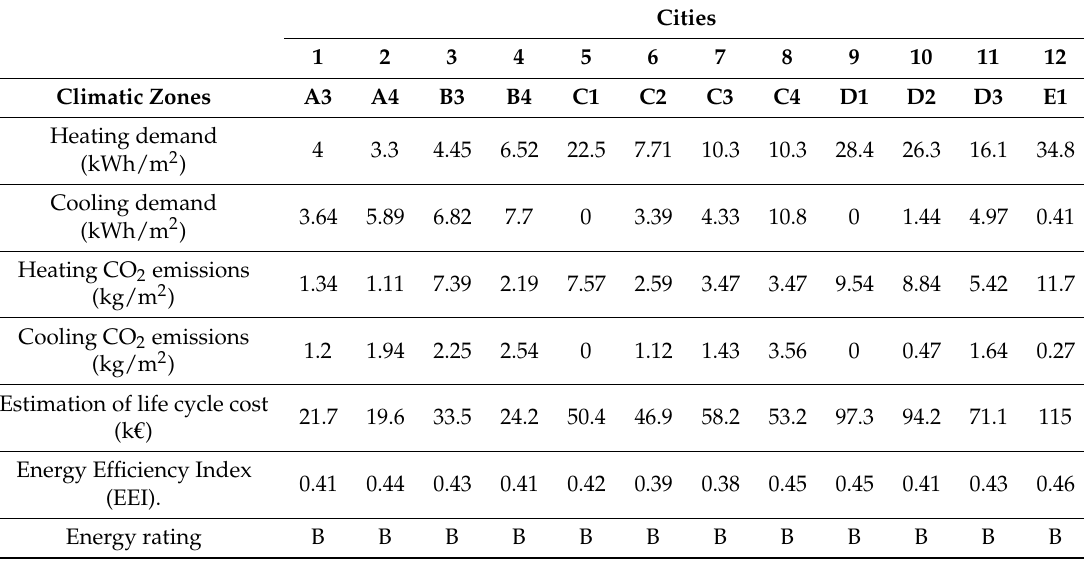
Table 5. Building envelope optimization.